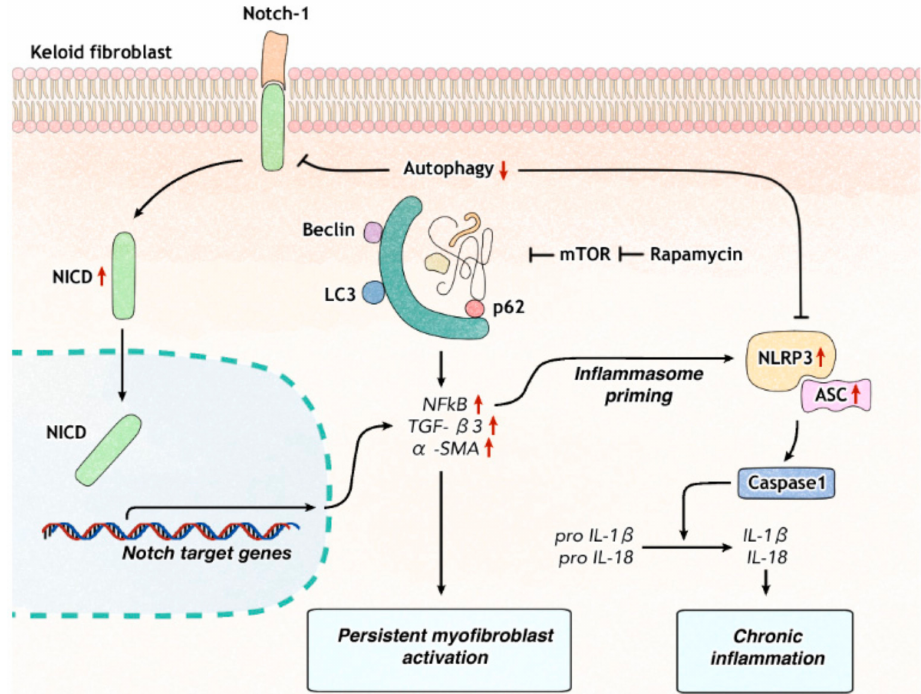
Figure 6. Model for roles of Notch signaling in keloid formation. Autophagy regulates degradation of Notch-1 in dermal fibroblasts. Decreased autophagy in keloid fibroblasts increases the level of Notch intracellular domain (NICD) and enhances the transcription of Notch target genes such as NF- κ B, which primes NLRP3 inflammasome proteins and subsequent inflammatory cascade. Notch1 inhibition can suppress NLRP3 inflammasome activation and fibrosis. Rapamycin induces autophagy in keloid fibroblasts, which result in decreased Notch1, NLRP3 inflammasome proteins, and TGF- β